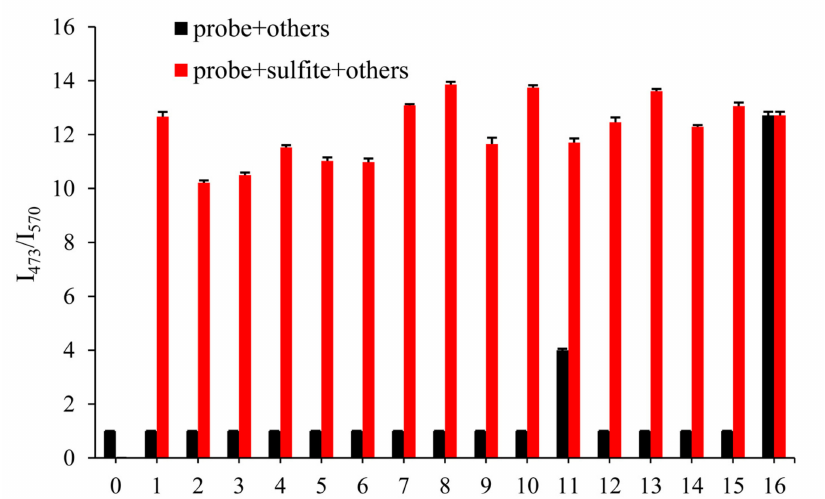
Figure 2. Fluorescence intensity of probe EB (10 µ M) in PBS solution (pH 7.4) upon addition of various reactive sulphur and other anions (500 µ M). 1. CO 32 − , 2. HCO 3 − , 3. Ac − , 4. PO 43 − , 5. HPO 42 − , 6. H 2 PO 4 − , 7. Cl − , 8. Br − , 9. I − , 10. NO 2 − , 11. S 2 − , 12. SO 42 − , 13. Hcy, 14. Cys and 15. GSH, 16. SO 32 − . For λ ex = 380 nm, λ em = 473 slits: 5.0 / 5.0 nm; for λ ex = 485 nm, λ em = 570 nm slits: 10.0 / 10.0